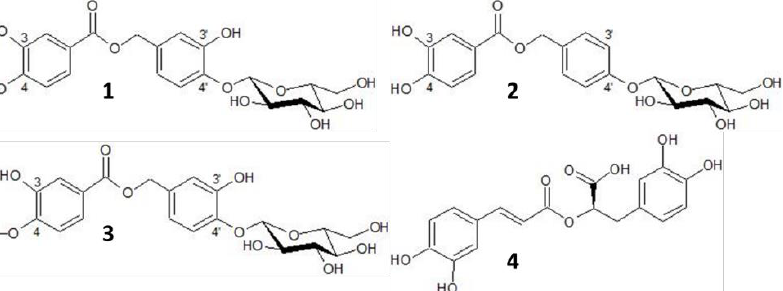
Figure 6. Chemical structures of the four main phenolic compounds in the EtOH-extracts of ore- gano: 4′ - O - β -D-glucopyranosyl- 3′ , 4′ -dihydroxybenzyl protocatechuate (oreganol A) ( 1 ), 4′ - O - β -D- glucopyranosyl- 4′ -hydroxybenzyl protocatechuate ( 2 ), 4′ - O - β -D-glucopyranosyl- 3′ , 4′ -dihy- droxybenzyl 4- O -methylprotocatechuate (oregano B) ( 3 ), rosmarinic acid ( 4 ).